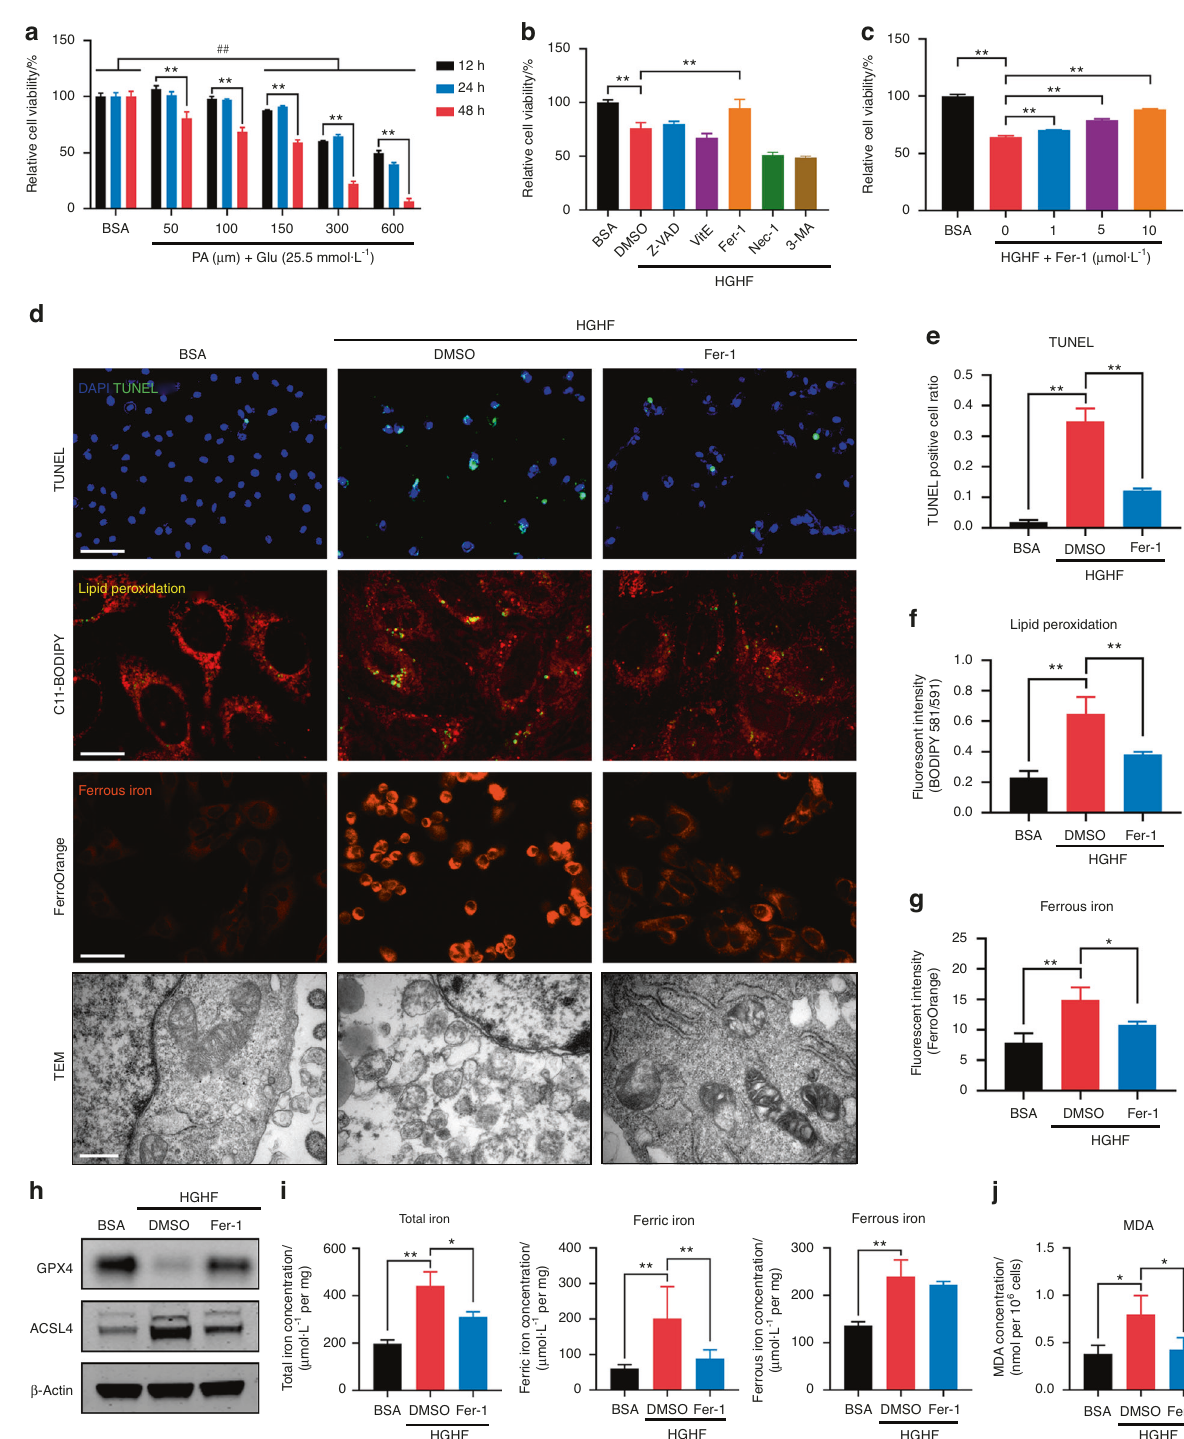
Fig. 2 HGHF-induced osteocyte ferroptosis in vitro. a Osteocytes were treated with BSA (5.5 mmol·L − 1 glucose) or various concentrations of PA (25.5 mmol·L − 1 glucose) for different times and evaluated with a CCK ‐ 8 assay. b CCK-8 assay of osteocytes pretreated with DMSO (solvent), Z-VAD-FMK (an apoptosis inhibitor), VitE (a ROS scavenger), Fer-1 (a ferroptosis inhibitor), Nec-1 (a necroptosis inhibitor) or 3-MA (an autophagy inhibitor) and then subjected to HGHF treatment for 24 h. c CCK-8 assay of osteocytes pretreated with various concentrations of Fer-1 and then subjected to BSA or HGHF treatment for 24 h. d Osteocytes treated with BSA, HGHF or HGHF + Fer-1 for 24 h. Representative images of the TUNEL assay (scale bar: 100 μ m), C11-BODIPY staining (scale bar: 25 μ m), FerroOrange staining (scale bar: 100 μ m), and TEM (scale bar: 0.5 μ m) images are presented. e Semiquantitative analysis of TUNEL-positive cells. Semiquantitative analysis of the fl uorescence intensity of lipid peroxides ( f ) and ferrous iron ( g ). h WB analysis of the expression of GPX4 and ACSL4 in osteocytes. i Total iron, ferrous iron, and ferric iron levels in osteocytes were quantitatively determined using an iron assay kit. j MDA levels in osteocytes were quantitatively determined using an MDA assay kit. “ * ” indicates comparison between the two indicated groups, and “ # ” indicates comparison with the BSA group at 24 h. * P < 0.05; “ ** ” and ## P < 0.01. All data are from n = 3 independent